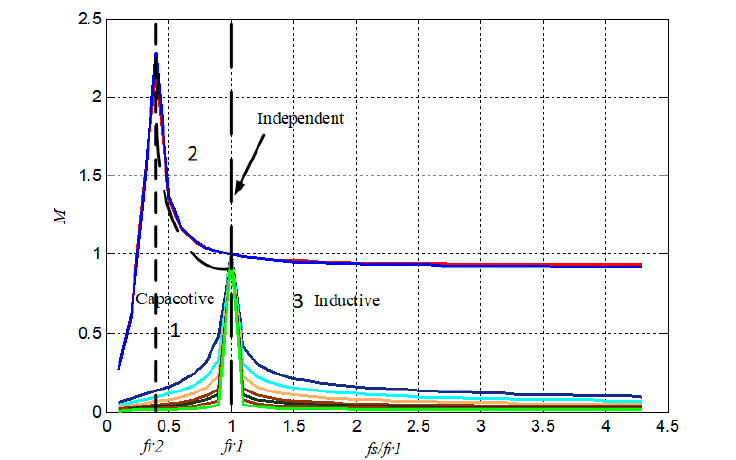
Figure 3. Voltage gain vs. frequency ratio.